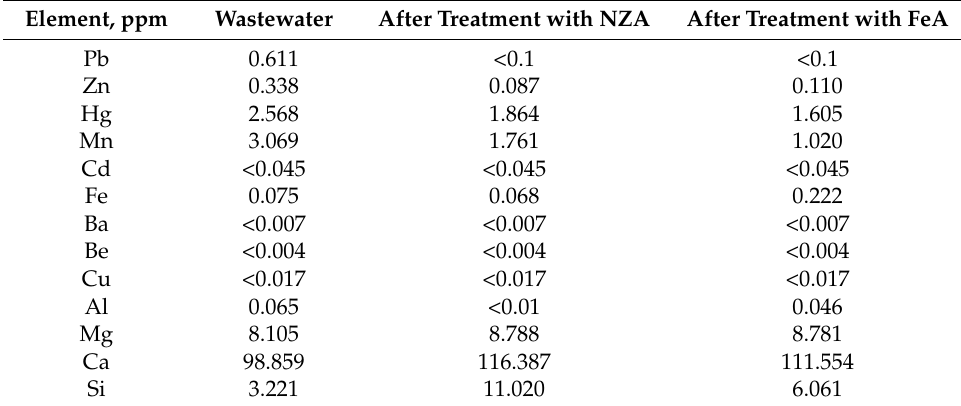
Table 7. Preliminary investigations of using NZA and FeA as cleaner of mining